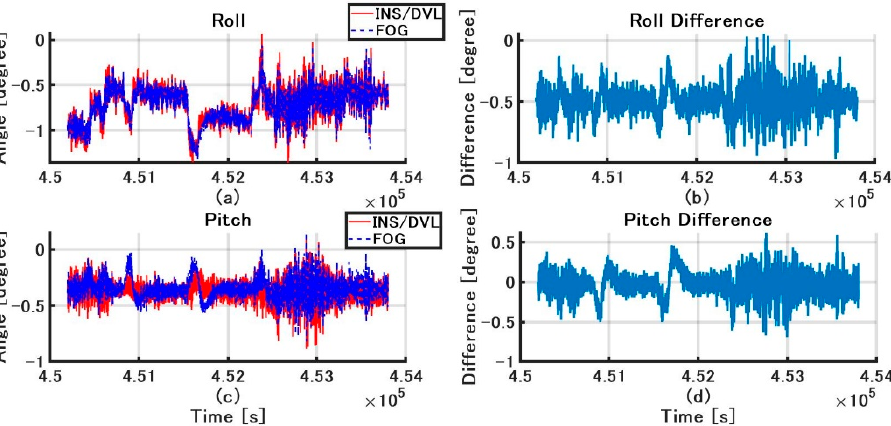
Figure 12. ( a ) Roll angle of INS/DVL and FOG; ( b ) Roll difference between INS/DVL and FOG; ( c ) Pitch angle of INS/DVL and FOG; ( d ) Pitch difference between INS/DVL and FOG.